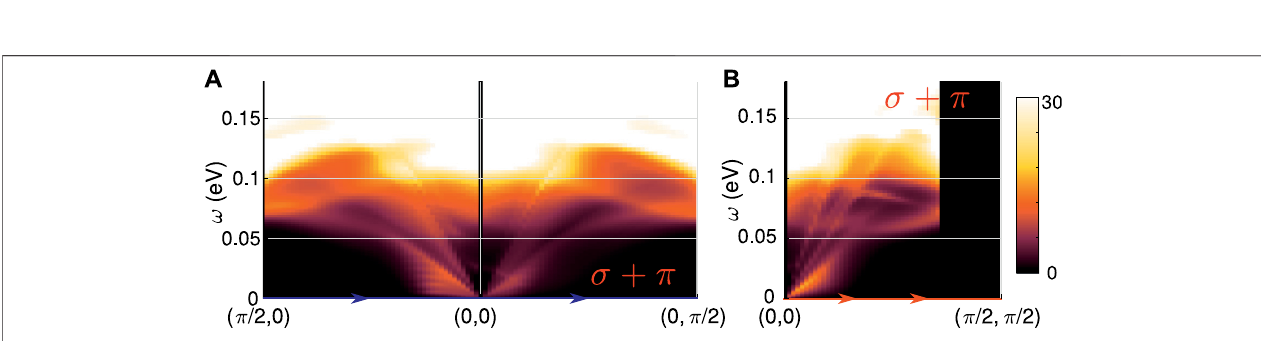
FIGURE5| RIXS intensity without orbitalincoherence. Same as Figure 3 , but calculated using Z l = 1and by setting U = 0.36eV, J = U /6 asdiscussed inRef. [33].